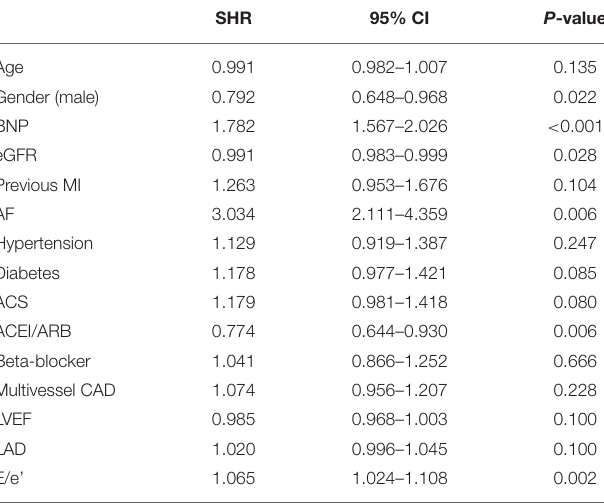
TABLE 2 | Multivariate analysis showing predictors of new-onset HF.